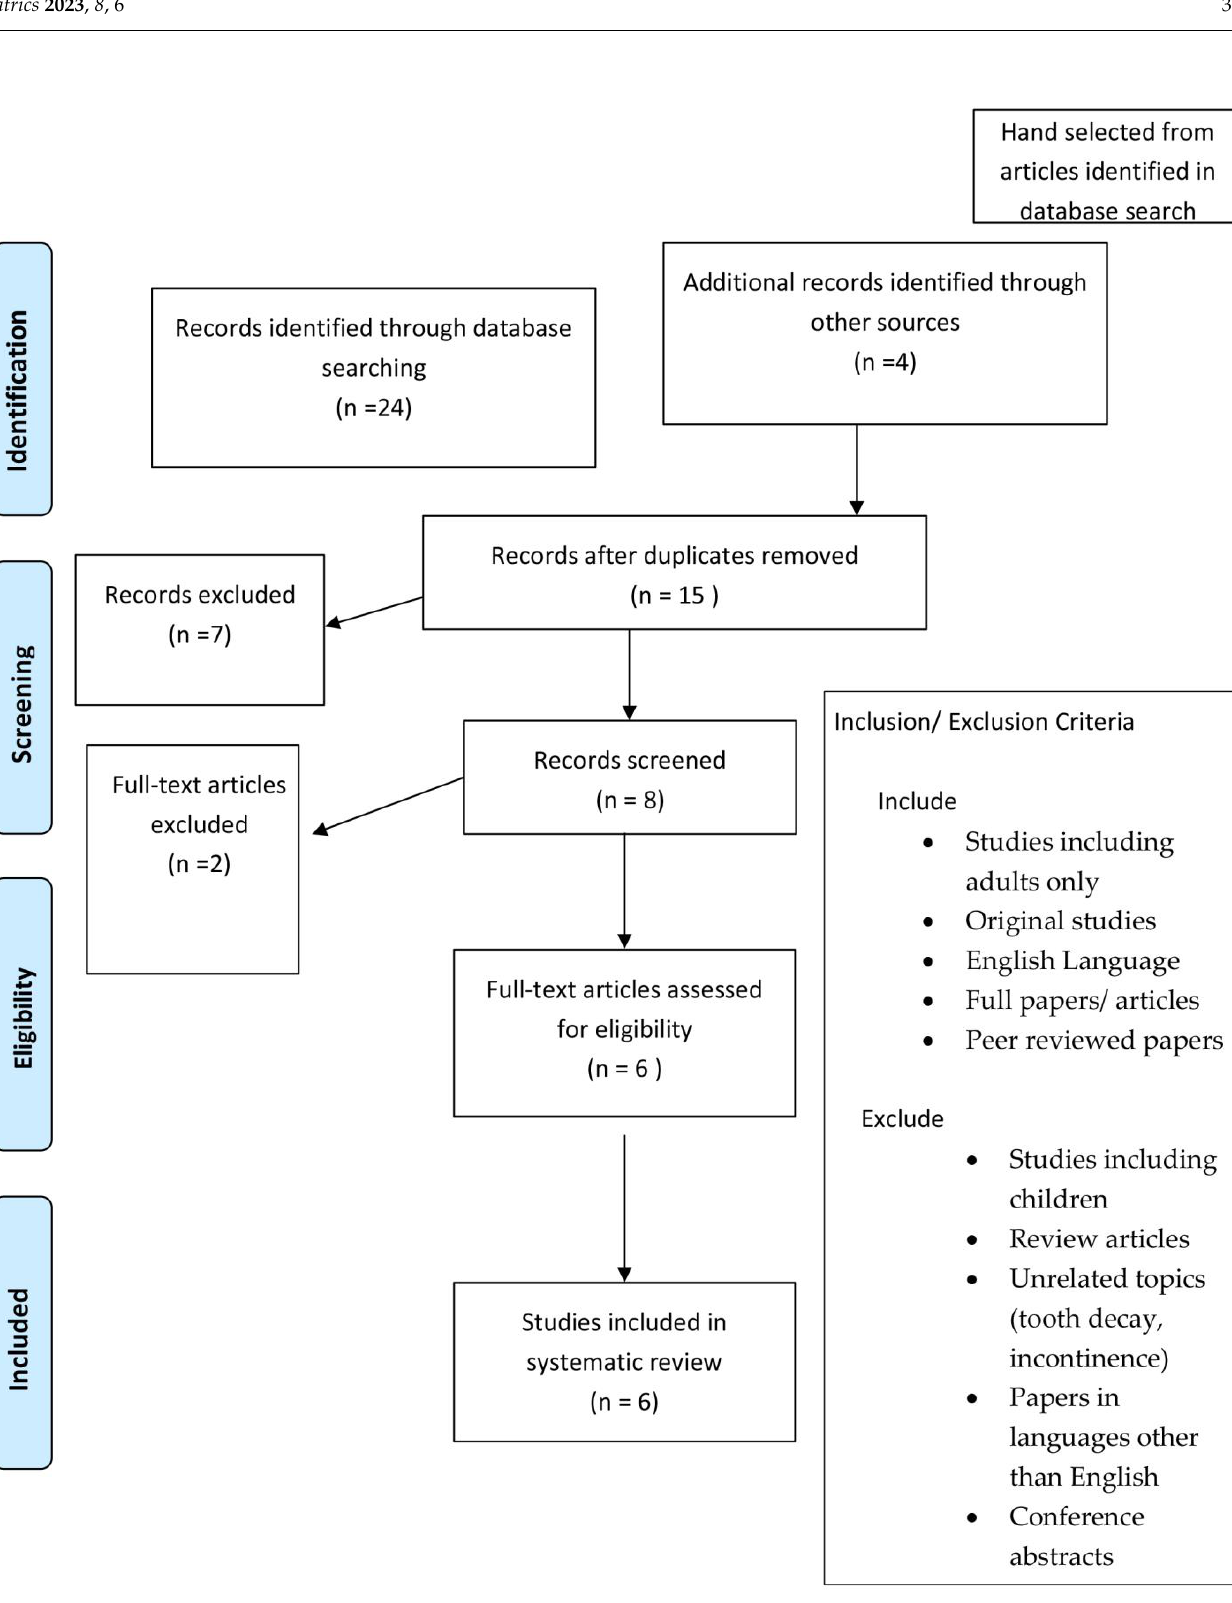
Figure 1. PRISMA 8 flow diagram: systematic review papers.